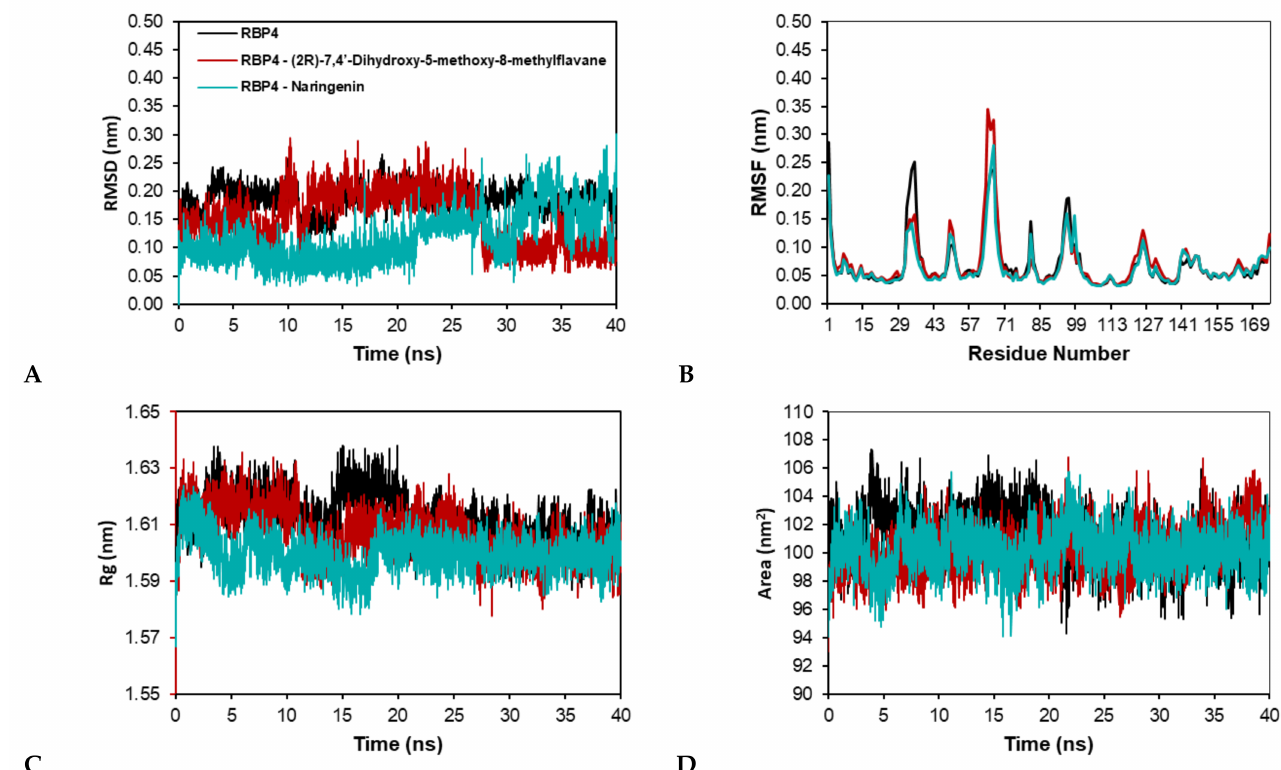
Figure 6. Molecular dynamic simulation trajectory analysis of RBP4, and RBP4-ligand complexes during 40 ns simulation. Molecular dynamic simulation trajectory analysis of RBP4-ligand com- plexes during 40 ns simulation. ( A ) RMSD of backbone atoms for RBP4-ligand complex ( B ) RMSF of C α RBP4-ligand complex. ( C ) The radius of gyration (Rg) of backbone atoms. ( D ) SASA of RBP4-ligand